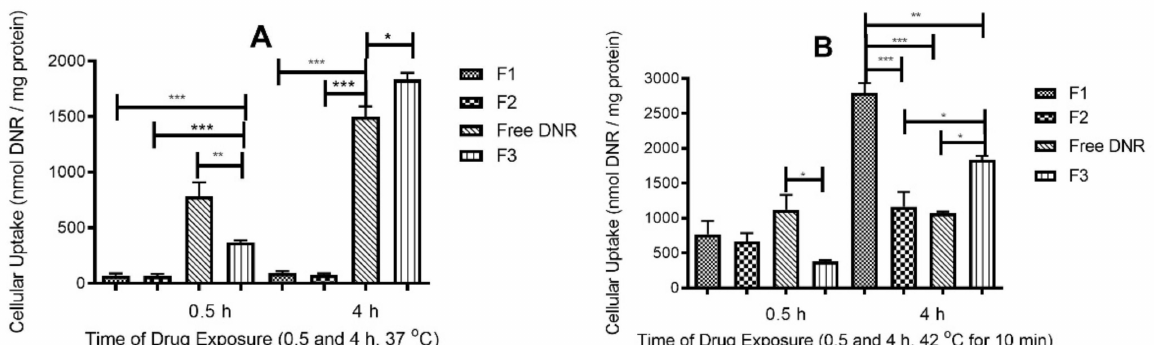
Figure 4. ( A ): Cellular uptake of TSLs DNR (14 µ M) at 37 ◦ C by MDA-MB-231 cancer cell lines. * indicates p < 0.05, ** indicates p < 0.01, and *** indicates p < 0.001. Values represent mean ± standard deviation ( n = 3). ( B ): Effect of TSLs enriched with CL on DNR uptake by MDA-MB-231 cancer cell lines after exposure to mild hyperthermia. * p < 0.05, ** p < 0.01, and *** p < 0.001. Values represent mean ± standard deviation ( n =